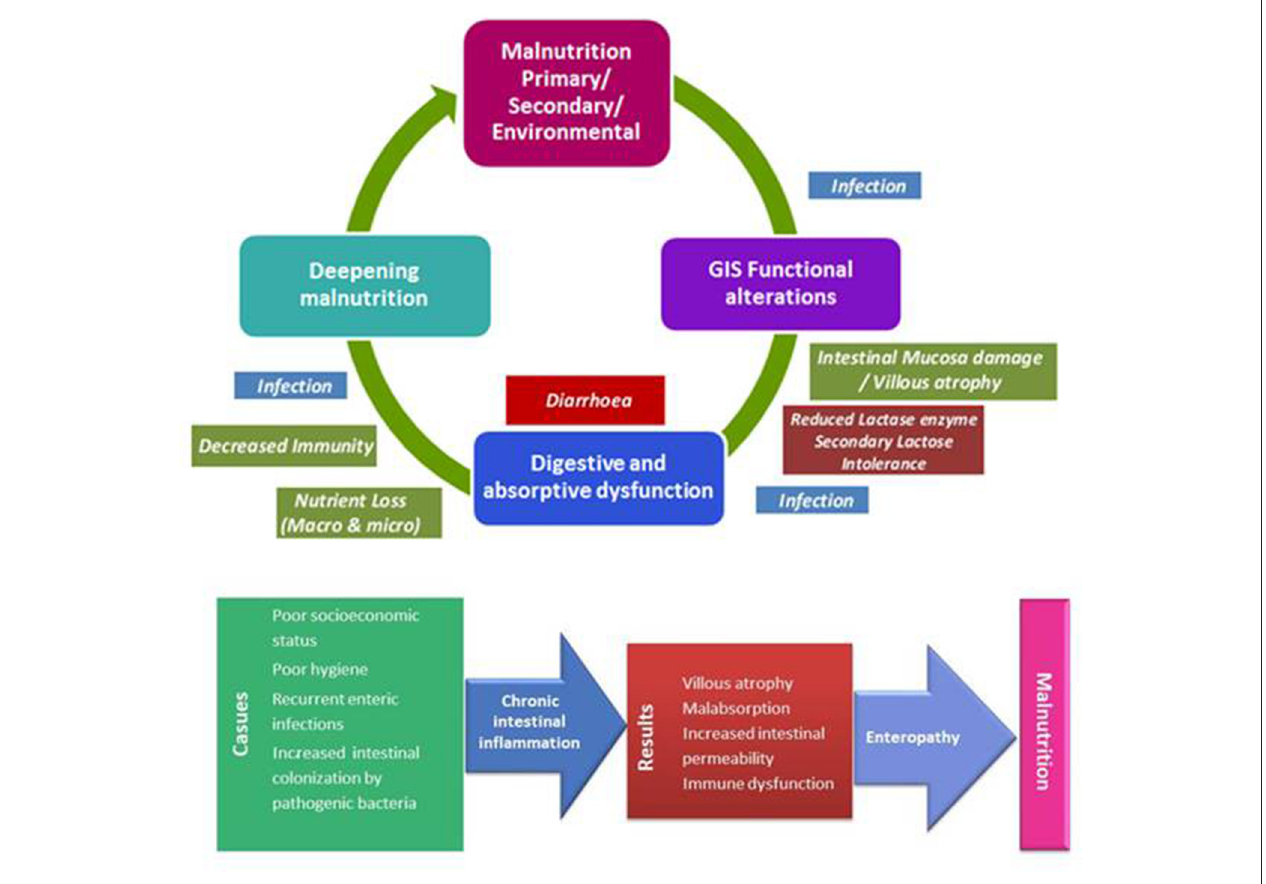
FIGURE 1 | Interplay between malnutrition and gastrointestinal functional alterations; environmental enteric